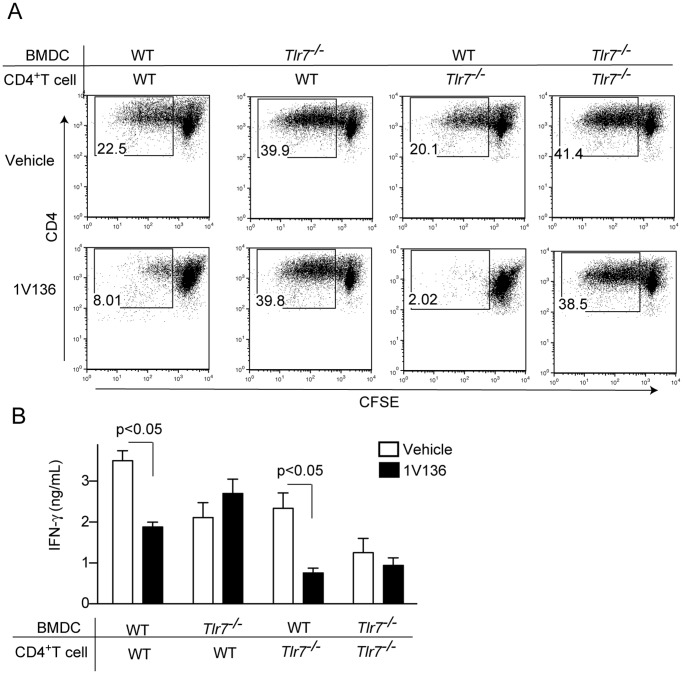
TLR7 ligand treatment selectively impaired dendritic cell and not T cell function.(A) CFSE-labeled CD4+ T cells were prepared from WT or Tlr7−/− mice immunized with OVA/CFA. WT or Tlr7−/− BMDCs were incubated with these primed CD4+ T cells with OVA (100 µg/mL) in the presence or the absence of 1V136 (1 µM) for five days. T cell proliferation was monitored by flow cytometry. Representative plots are shown from three experiments. (B) The culture supernatants were assessed for IFN-γ levels by ELISA. The data shown are representative of two independent experiments. p<0.05 by Student t test compared to vehicle control.